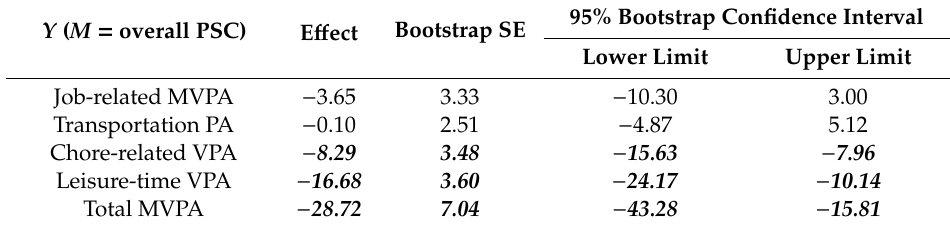
Table 3. The mediating e ff ects of overall